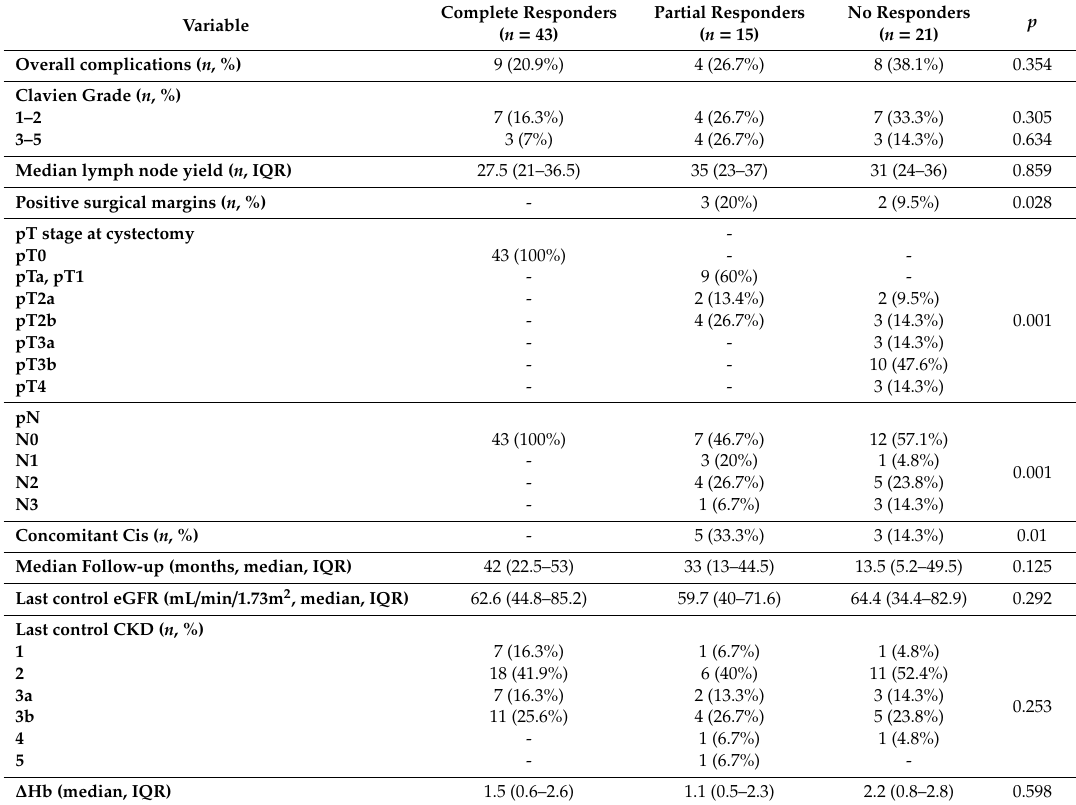
Table 2. Perioperative, pathologic, and functional data according to NACT response 2